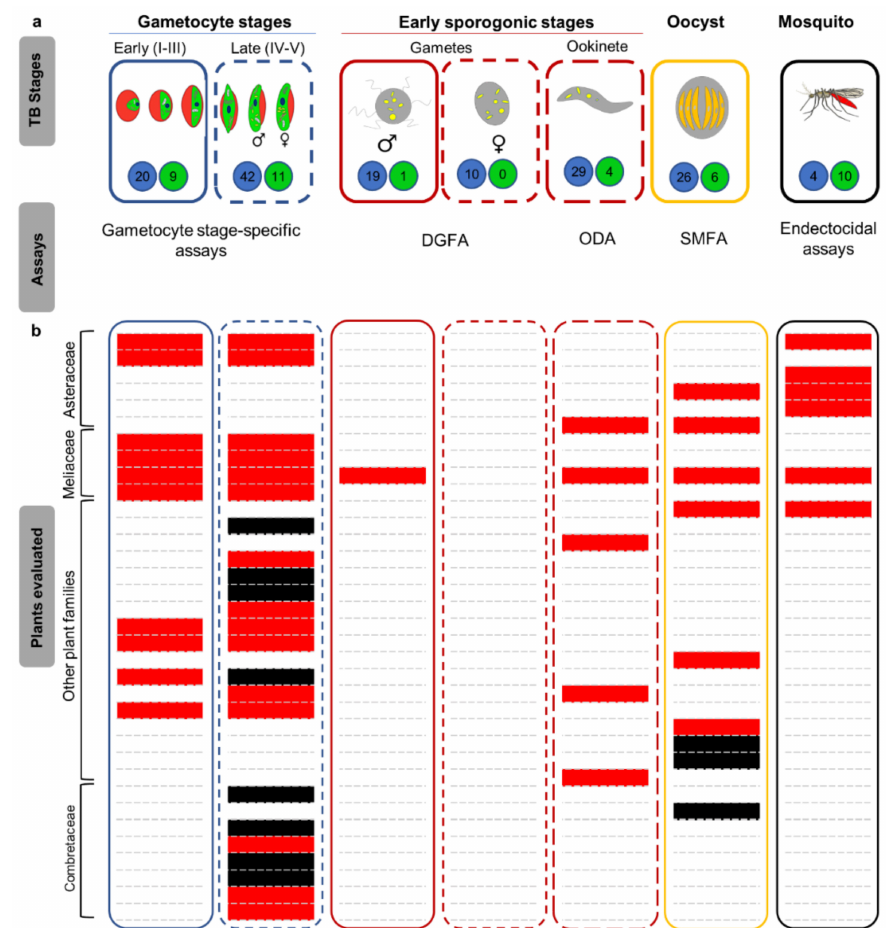
Figure 1. Overview of transmission-blocking assays and natural product origins. ( a ) Sexual stages within the human host are categorised into early-stage (I–III) and late-stage (IV–V) gametocytes. Gametocytes are sexually dimorphic with both male (micro-) and female (macro-) gametocytes found in human host at a ratio of ~1:3.6, respectively. Inside the mosquitoes’ midgut, micro-gametocytes develop into mature micro-gametes, a process called exflagellation. Each micro-gametocyte produces eight micro-gametes while a macro-gametocyte matures into a single macro-gamete. Gametocyte development into gametes is termed gametogenesis. Micro- and macro-gametes fuse together to form a zygote that develops into a motile ookinete. Gamete-zygote-ookinete development constitute early sporogonic stages (ESS). Ookinetes penetrate the midgut wall where they form oocysts which enlarge over time and eventually rupture to release sporozoites. Di ff erent assay platforms to assess the activity against di ff erent stages include gametocyte stage specific assays (which assess either development, viability, metabolic or redox status), dual gamete formation assays (DGFA) (examine development of mature gametocytes into either micro- or macro-gametes), ookinete development assay (ODA) (examines development of gametes to ookinetes), standard membrane feeding assay (SMFA, assess either the number of oocysts per mosquito (termed oocyst intensity) or total number of mosquitoes with oocysts (termed oocysts prevalence) and endectocidal assays (which examine insecticidal properties of drugsuponingestionbymosquito). Numbersindicatedinblueandgreencirclesindicatenumberofpure natural compounds and plant extracts screened per each respective stage. TB–transmission-blocking. ( b ) Summary of plant species reviewed for activity against transmission-blocking stages. Quite noticeable is the lack of investigations on gametes. It is also evident that the Asteraceae, Meliaceae and Combretaceae are the most investigated plant families with most species from the latter family being inactive against the respective transmission-blocking stages they were interrogated against. The colour scale indicates active (red) and inactive (black) plants species against specific